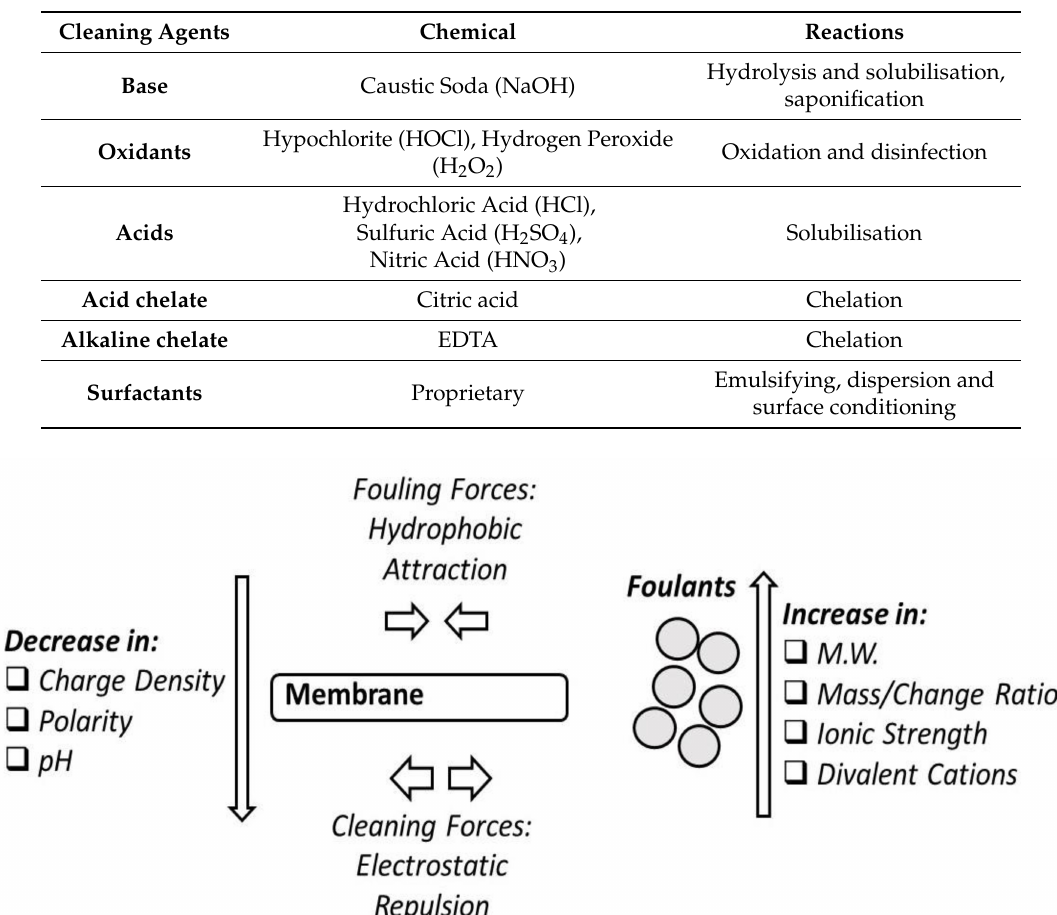
Table 4. Membrane cleaning agents and their acceptable physical-chemical mechanisms.